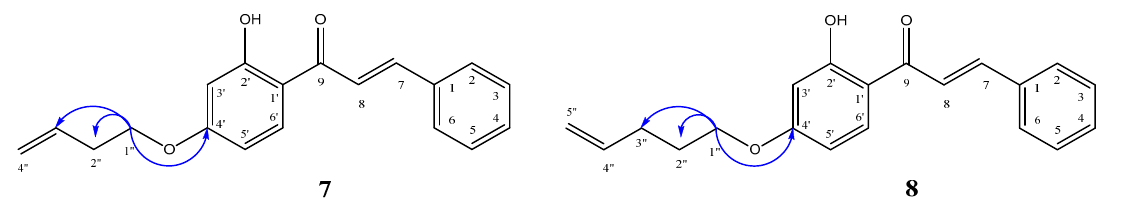
Figure 3. Most important correlations 2D 1 H– 13 C HMBC, compounds 7 and 8 .